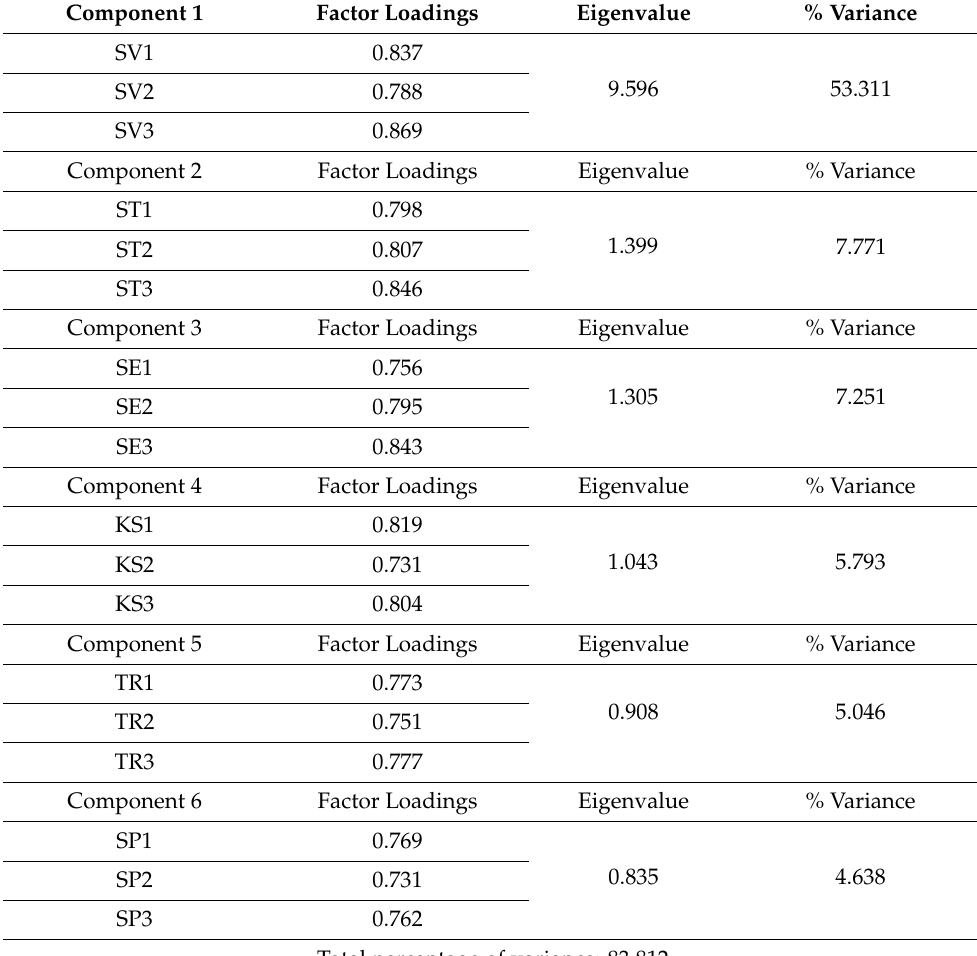
Table 2. Factors extraction results of the items in the